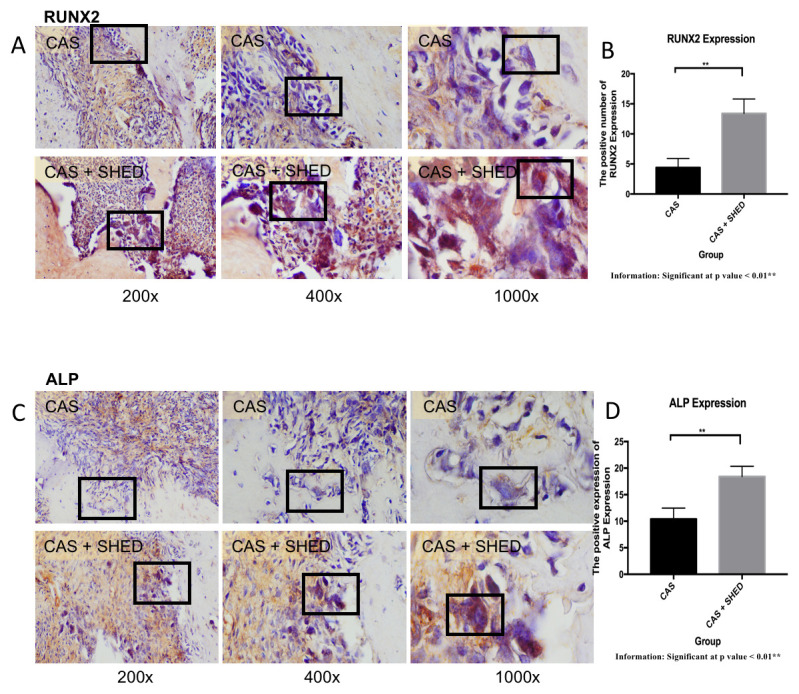
Histological sections of the Wistar rats’ (
R. Novergicus) afflicted periodontal tissues.Immunohistochemistry with antibody monoclonal (AbMo) and DAB were performed to examine the (
A) RANKL and (
B) OPG expressions. The positive cells were stained brown (black box) with a 200x, 400x, and 1000x magnification using a light microscope. The number of osteoblasts expressing (
C) RANKL and (
D) OPG in the alveolar bone of the rats.